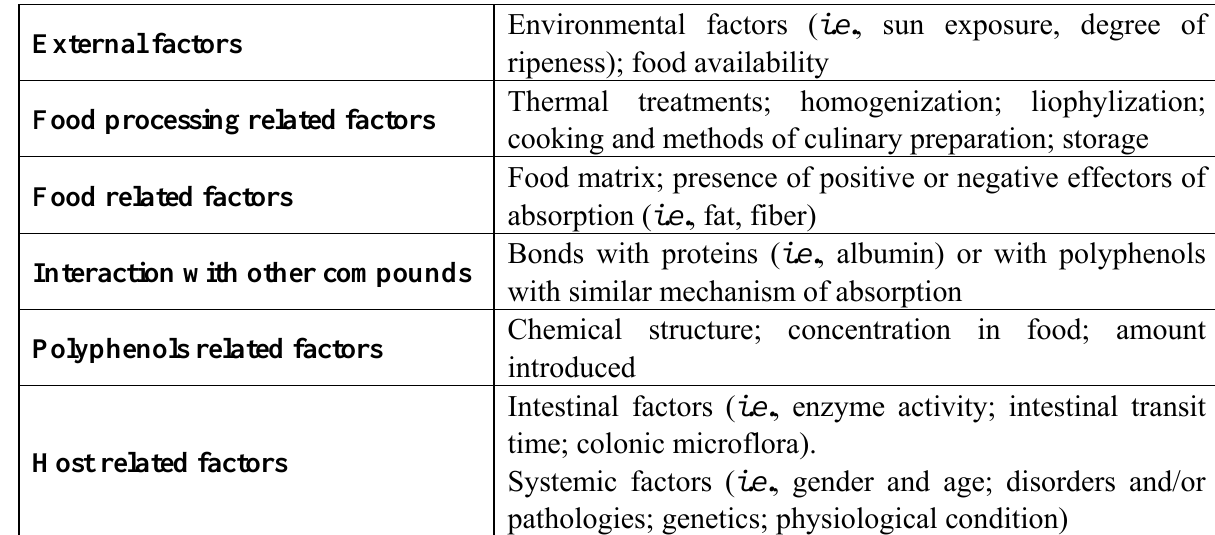
Table 1. Main factors affecting the bioavailability of dietary polyphenols in